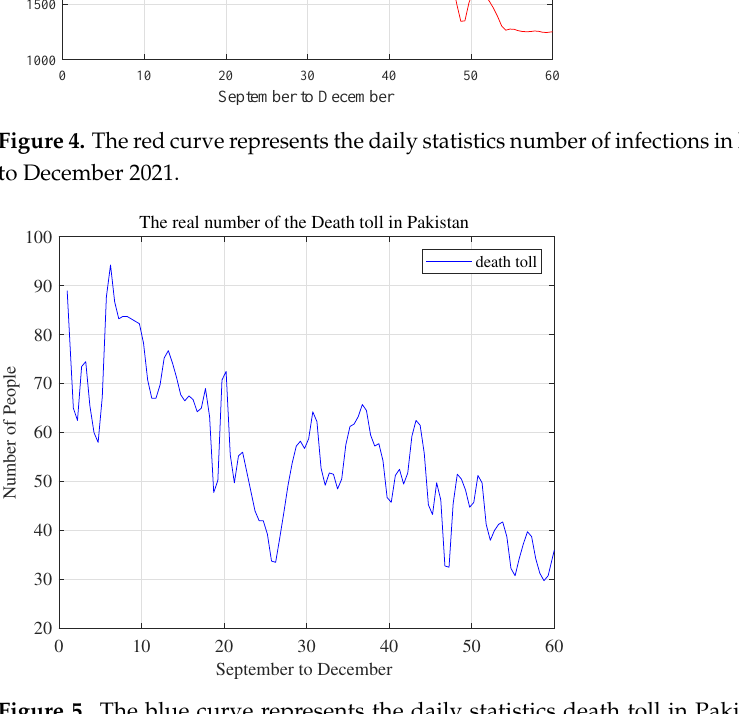
Figure 5. The blue curve represents the daily statistics death toll in Pakistan from September to December